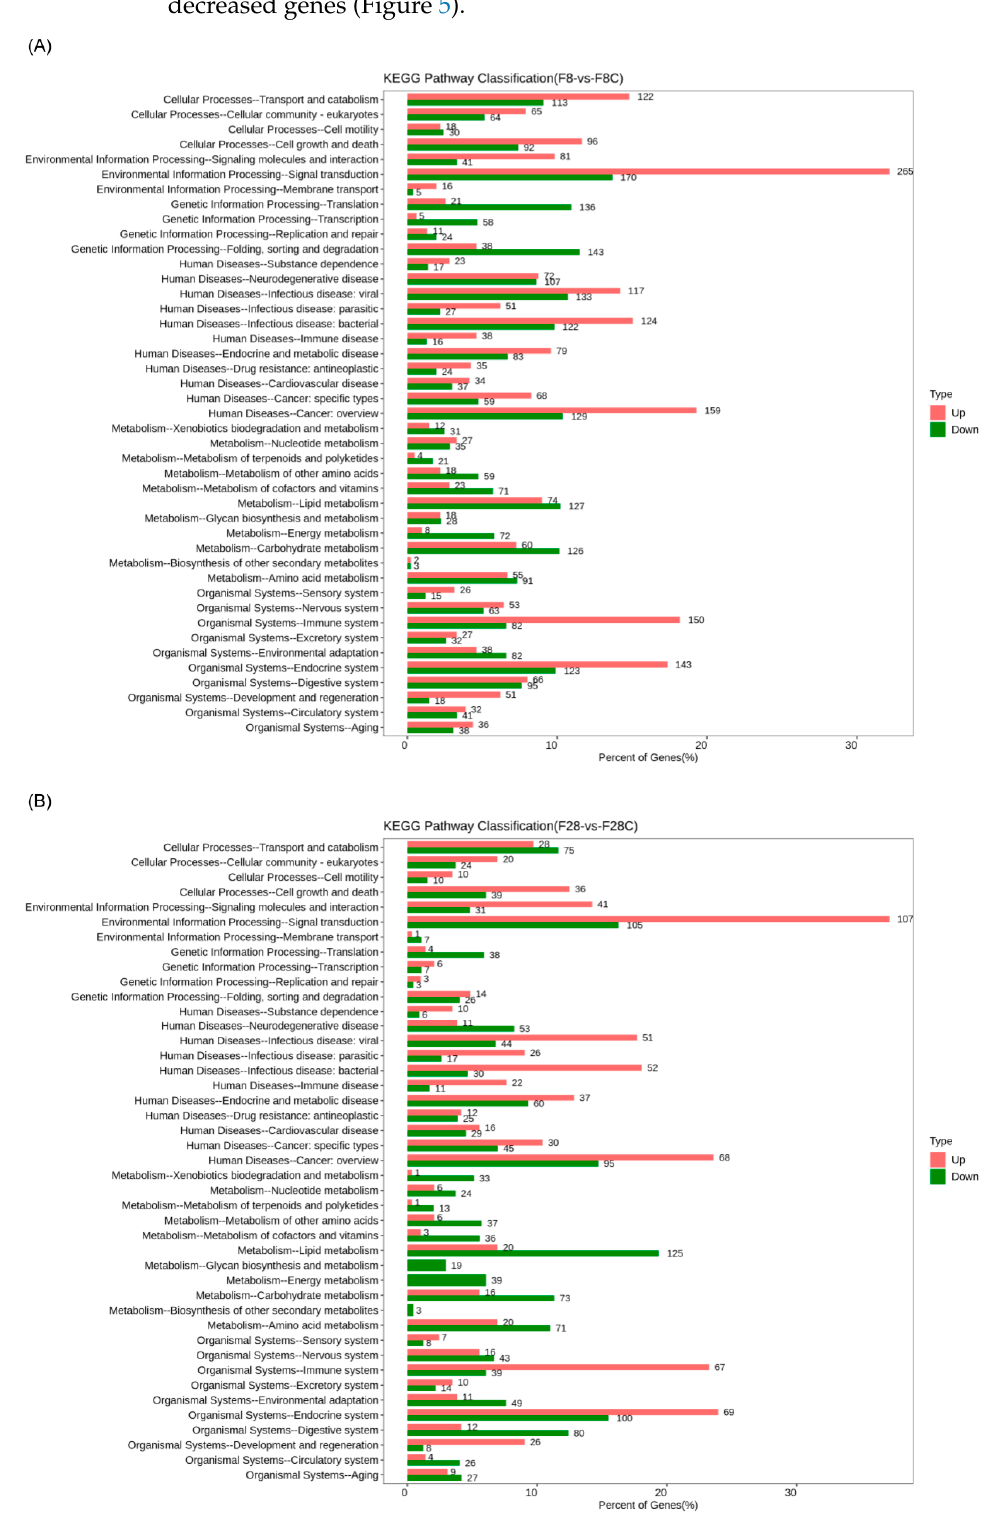
Figure 5. Kyoto Encyclopedia of Genes and Genomes pathway classification of significantly upregulated and downregulated genes in the liver transcriptome of yellowcheek starved for ( A ) 8 and ( B ) 28 d compared with the control groups at the same time.